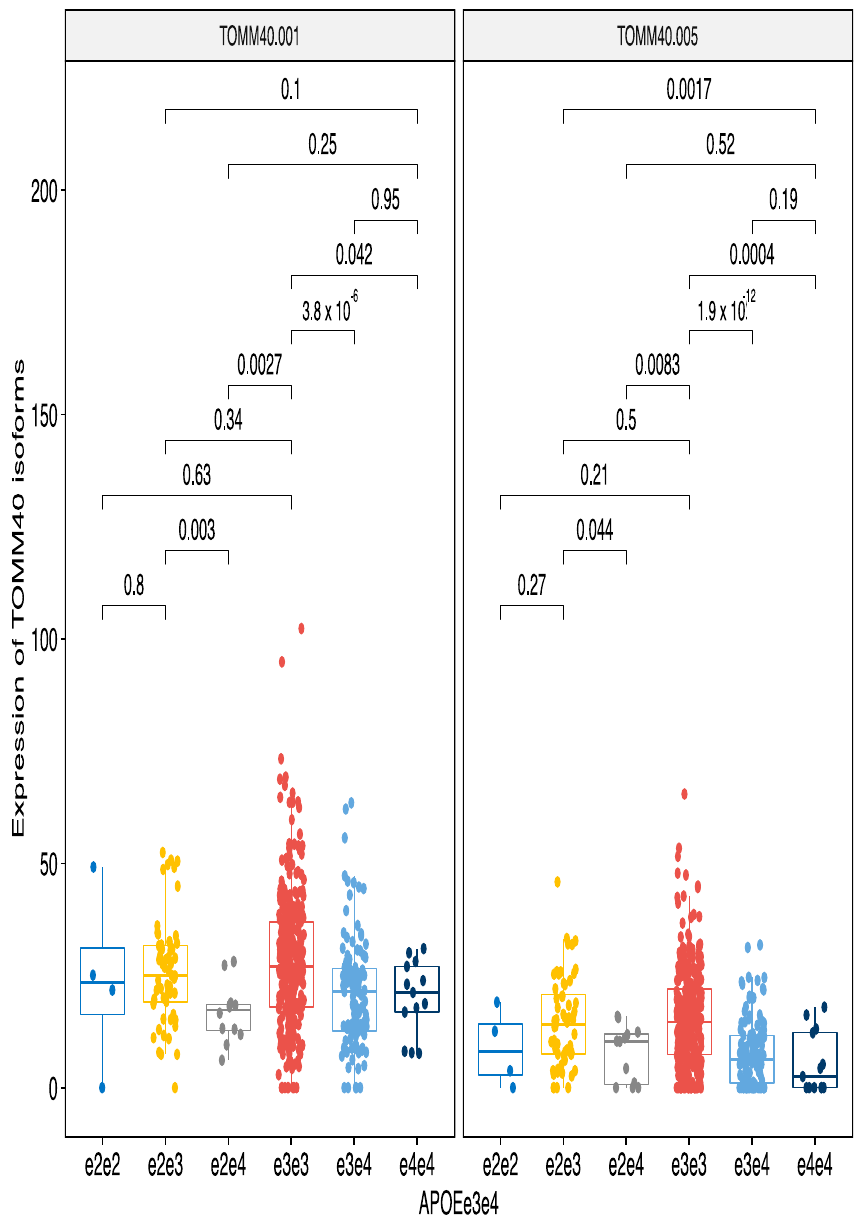
Figure 3. ApoE haplotypes regulate expression of the TOMM40 transcripts 001 and 005. ApoE e4 haplotype has statistically significantly lower expression than other haplotypes. Even a single e4 allele was sufficient to significantly reduce expression of the TOMM40 isoforms. The bars show pairwise comparisons and respective p -values after the Wilcoxon